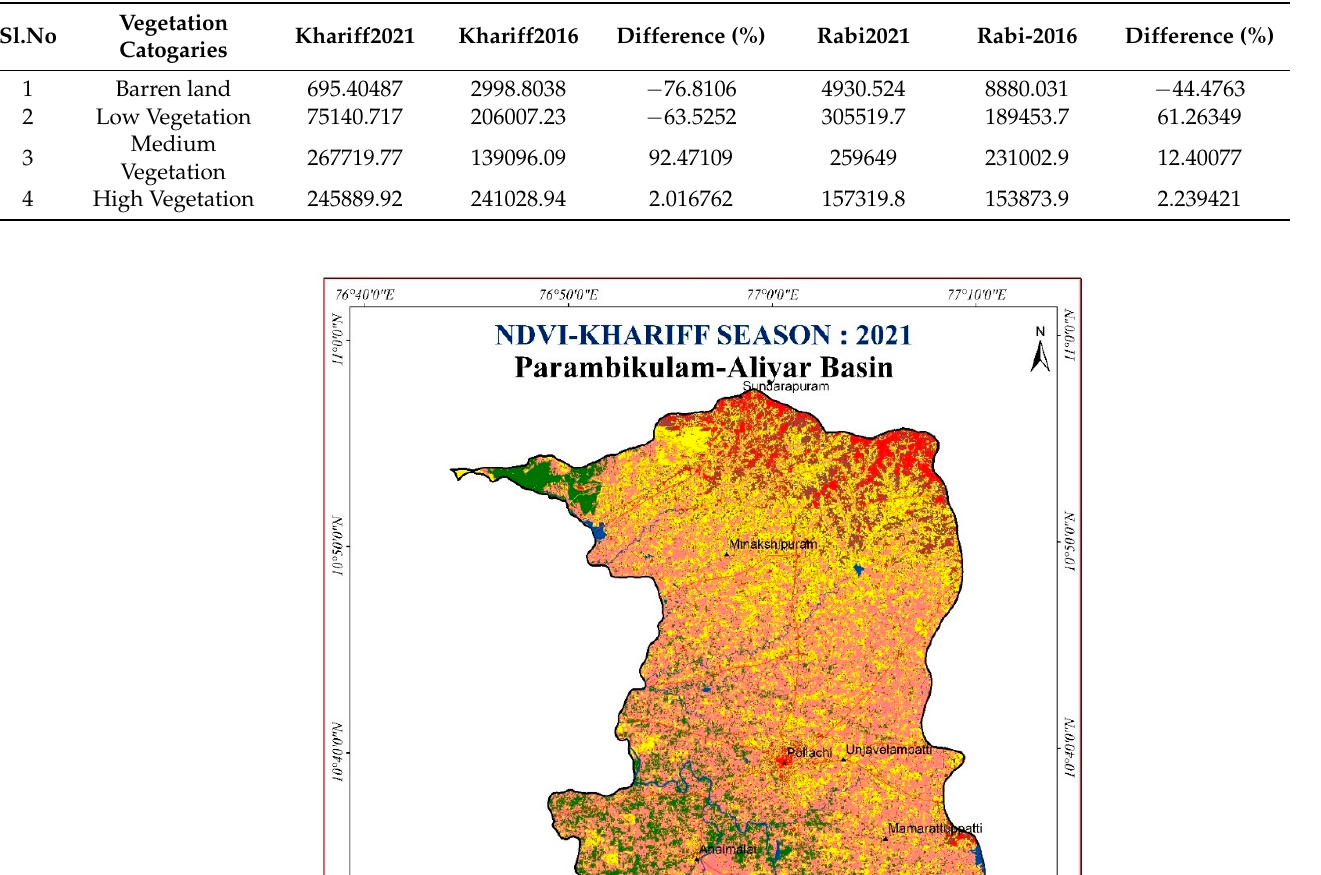
Table 1. Classification of vegetation types (area in acres) NDVI, 2021, variations during a normal year and drought year in PAP.